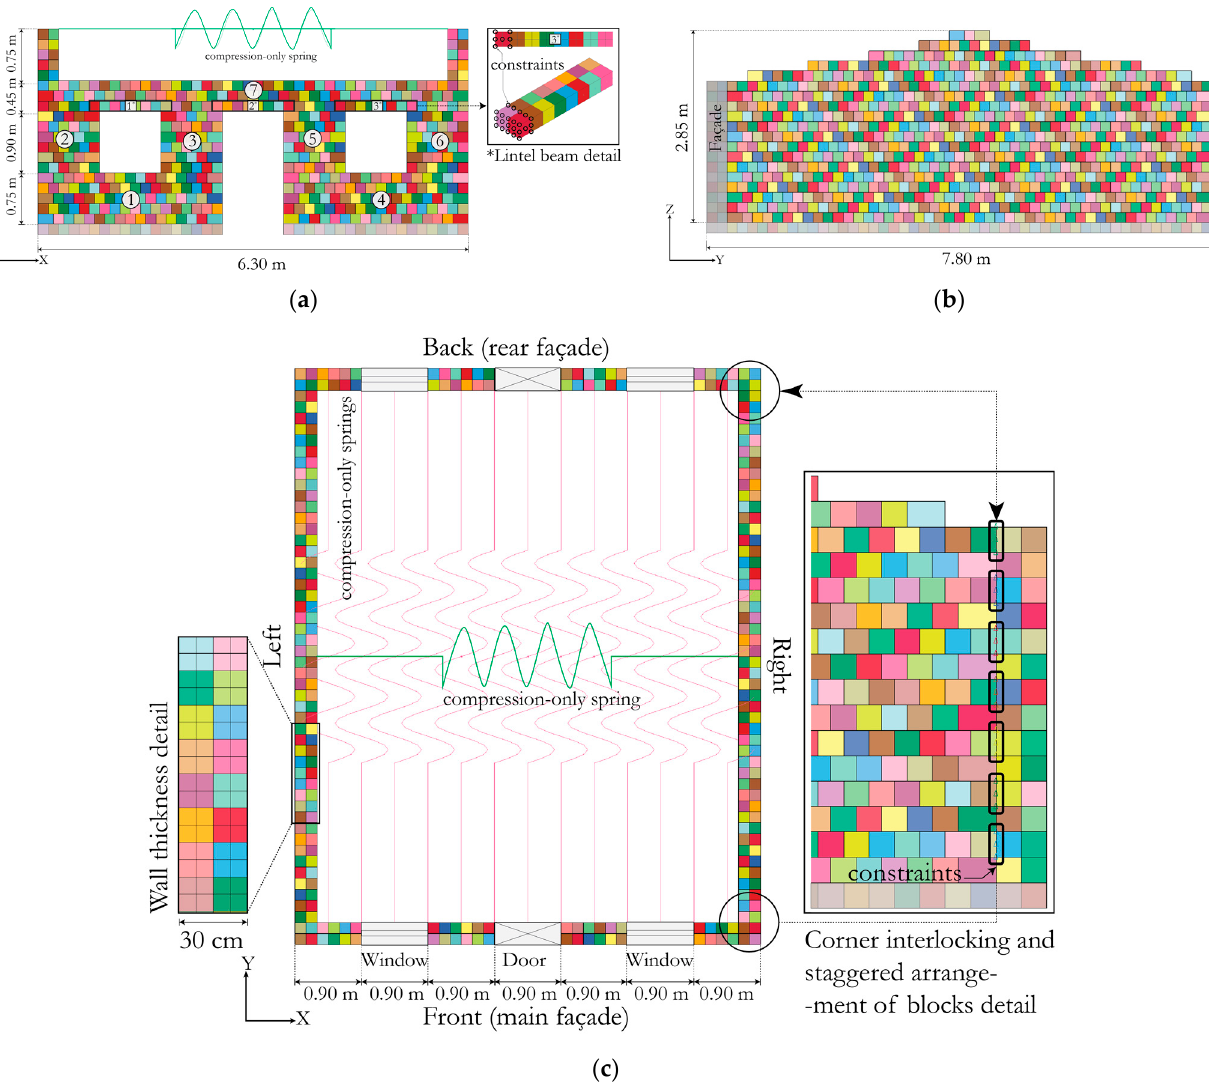
Figure 3. Dimensions of Building 1 and details of the modeling in the LS-DYNA environment: ( a ) elevation view showing the front (main façade), (inset right) close-up of a lintel beam; ( b ) elevation view showing the symmetric left and right gable end walls; ( c ) plan view of the building and position of compression-only springs: (left inset) wall thickness detail (right inset) close-up view of a corner intersection, constraints, and interlocking.